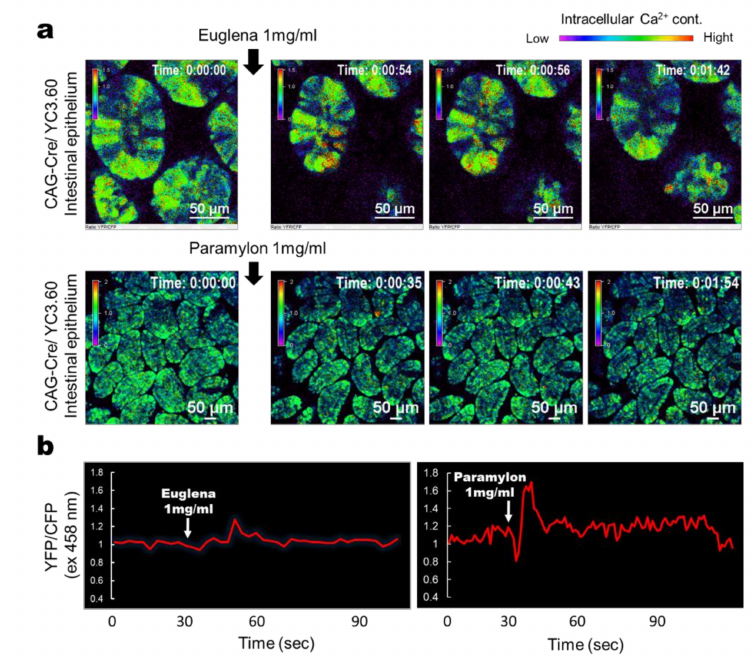
Figure 1. Intravital calcium (Ca 2 + ) signaling mediated by Euglena gracilis ( Euglena ) or paramylon in the intestinal tract. ( a ) Representative ratiometric Ca 2 + signaling images from the intestinal tract of a YC3.60 flox / CAG-Cre mouse with ubiquitous YC3.60 expression showing yellow fluorescent protein / cyan fluorescent protein (YFP / CFP) intensity at 458 nm excitation. Euglena or paramylon (0.1 mL) in phosphate bu ff ered saline (PBS) (1 mg / mL) was added at the indicated time point. The color scale indicates relative Ca 2 + concentration. ( b ) Time course of YFP / CFP fluorescence intensity at 458 nm excitation. Euglena or paramylon (0.1 mL) in PBS (1 mg / mL) was added at the indicated time point. Results are representative of at least three independent experiments ( n = 3 mice; scale bars, 50 µ m).